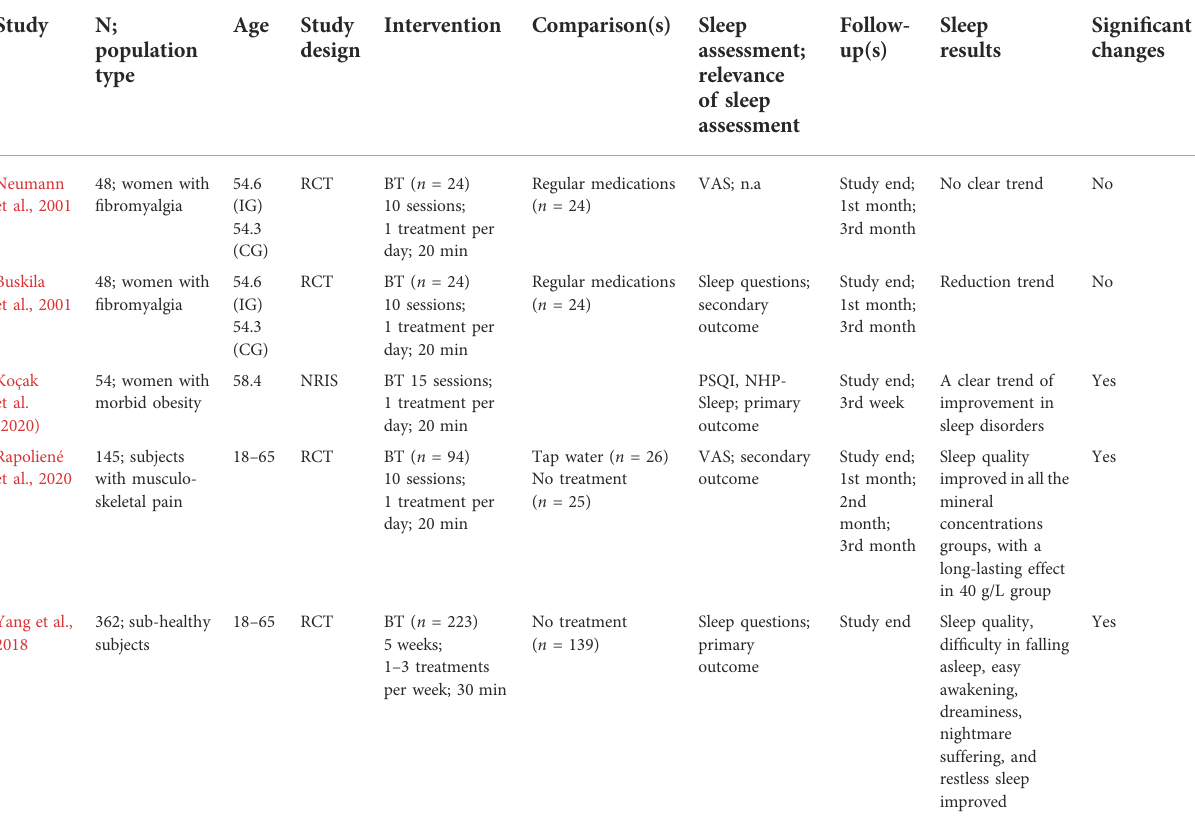
TABLE 1 Balneotherapy – Thermal water immersion